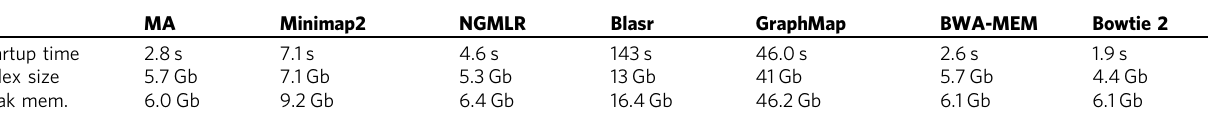
Table 1 Additional aligner